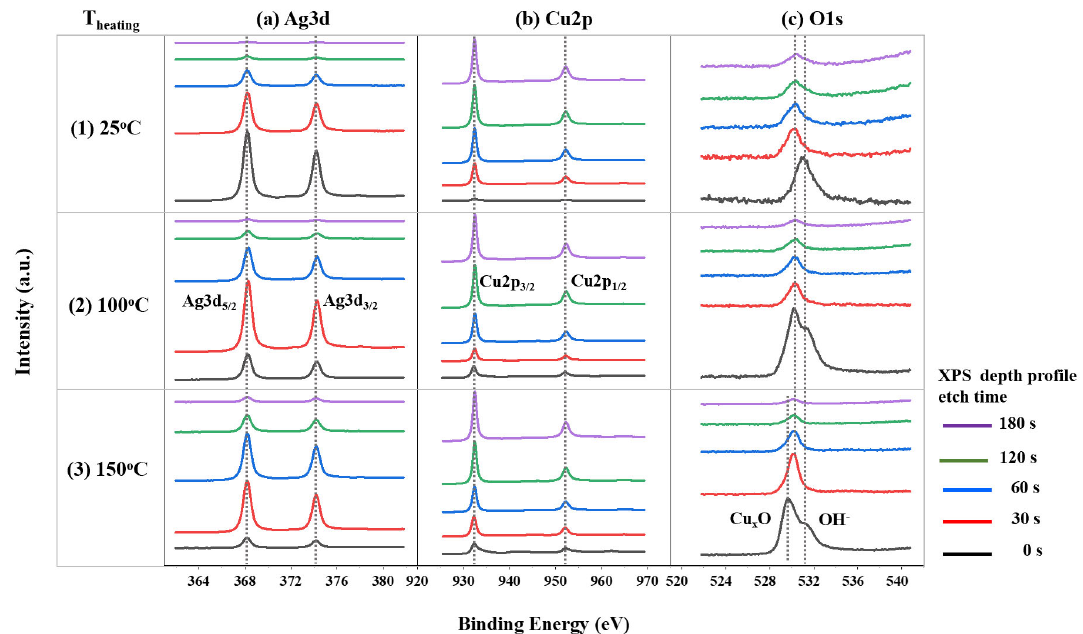
◦ C, 100 ◦ C, and 150 ◦ C: ( a ) Ag3d, ( b ) Cu 2p, and ( c ) O1s.